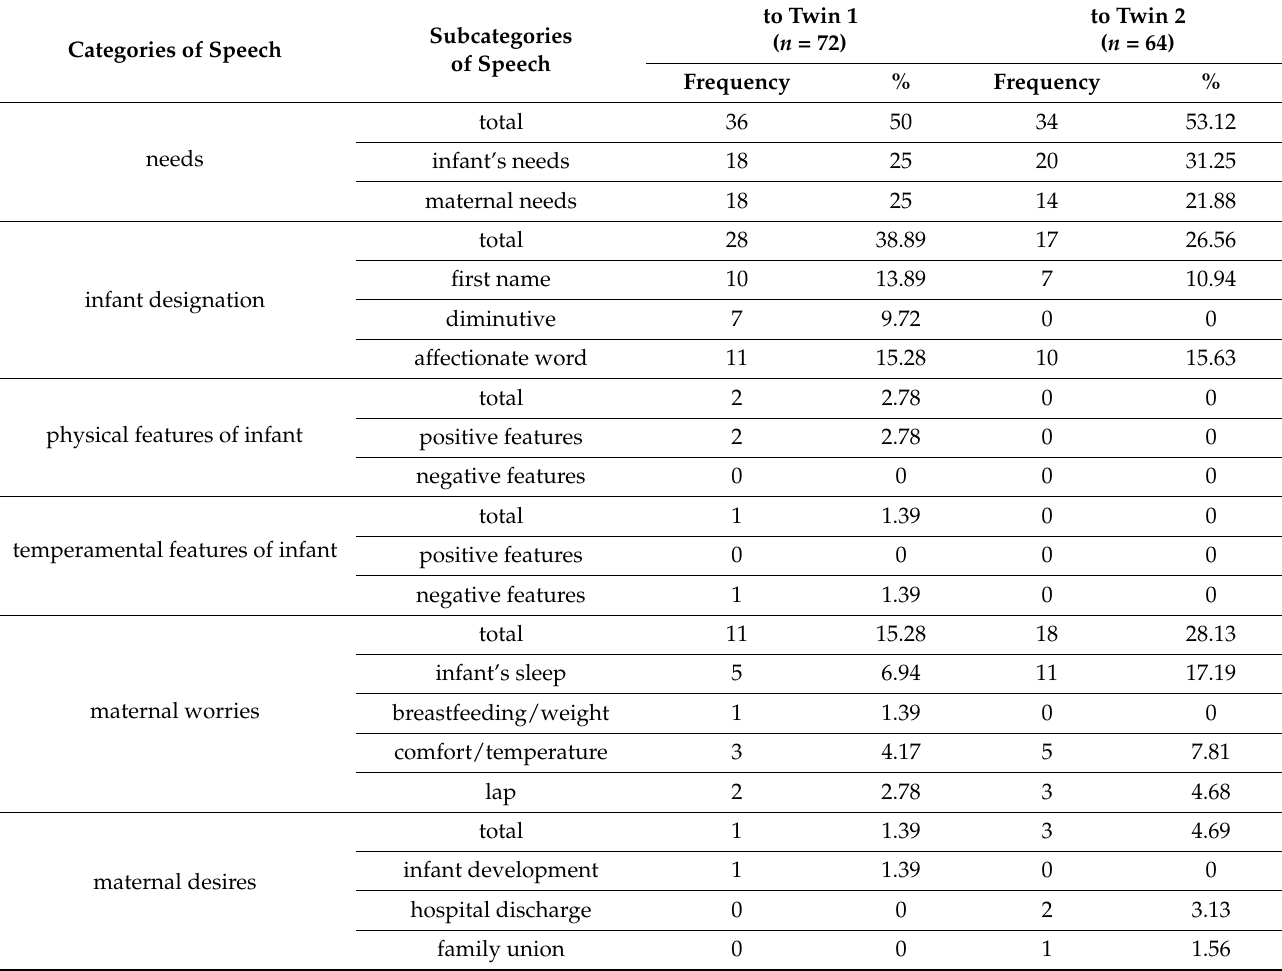
Table 6. Frequencies and proportions (according to the total of maternal speech vocalizations) of the speech contents directed to twin 1 and to twin